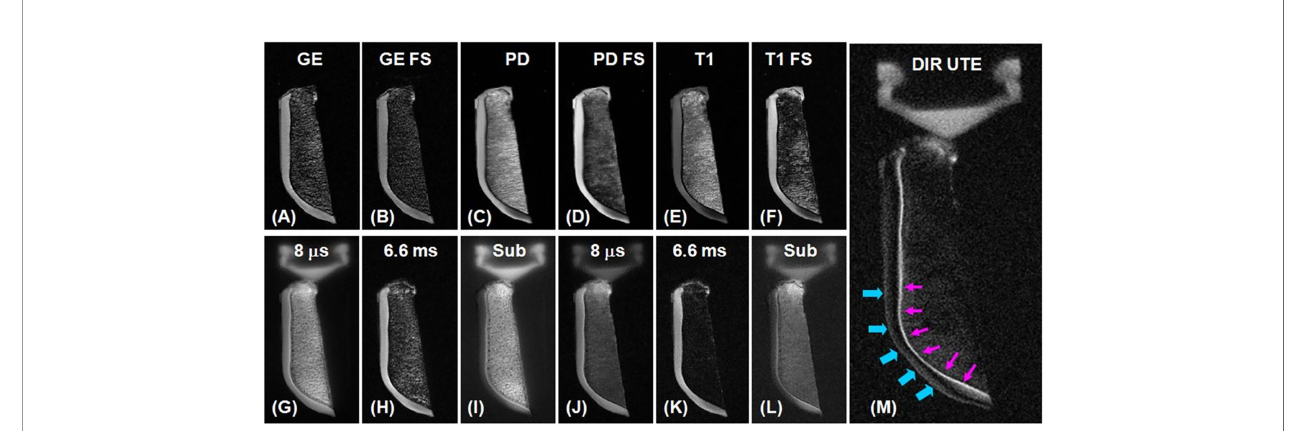
FIGURE 3 | Axial imaging of a slice of patella with clinical gradient echo sequence (GE) (A) , GE with fat saturation (FS) (B) , proton density-weighted fast spin echo (PD FSE) (C) , PD FSE with FS (D) , T 1 FSE (E) , T 1 FSE with FS (F) , conventional UTE with a TE of 8 m s (G) and 6.6 ms (H) , subtraction of the second from the fi rst echo (I) , fat-saturated UTE with a TE of 8 m s (J) and 6.6 ms (K) followed by corresponding later echo subtraction (L) , and dual inversion recovery (DIR) UTE (M) . Clinical GE and spin echo (SE)-FSE sequences do not show signal from deep radial and calci fi ed cartilage layers, which are brightly visualized in UTE sequences. There is limited contrast between not only the deep and super fi cial layers of cartilage, but also between the cartilage layers and bone marrow fat. The DIR UTE image illustrates the deep radial and calci fi ed cartilage layers with high contrast (pink arrows) and with good signal suppression from the super fi cial cartilage layers and fat. There is some residual signal from the super fi cial cartilage layers as a result of T 1 variations (imperfect nulling). Modi fi ed, with permission from Ref